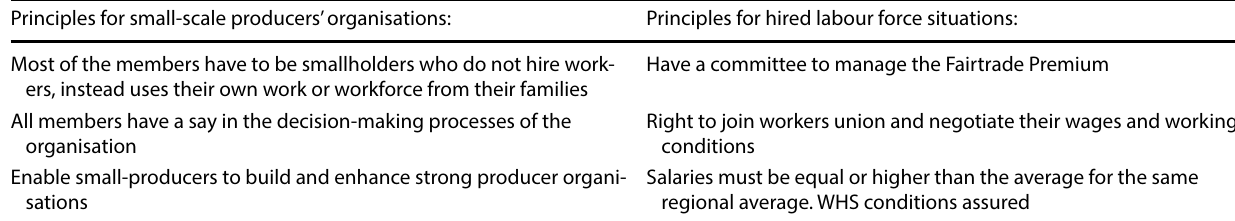
Table 2 Principles set for the two types of producers from Fairtrade International